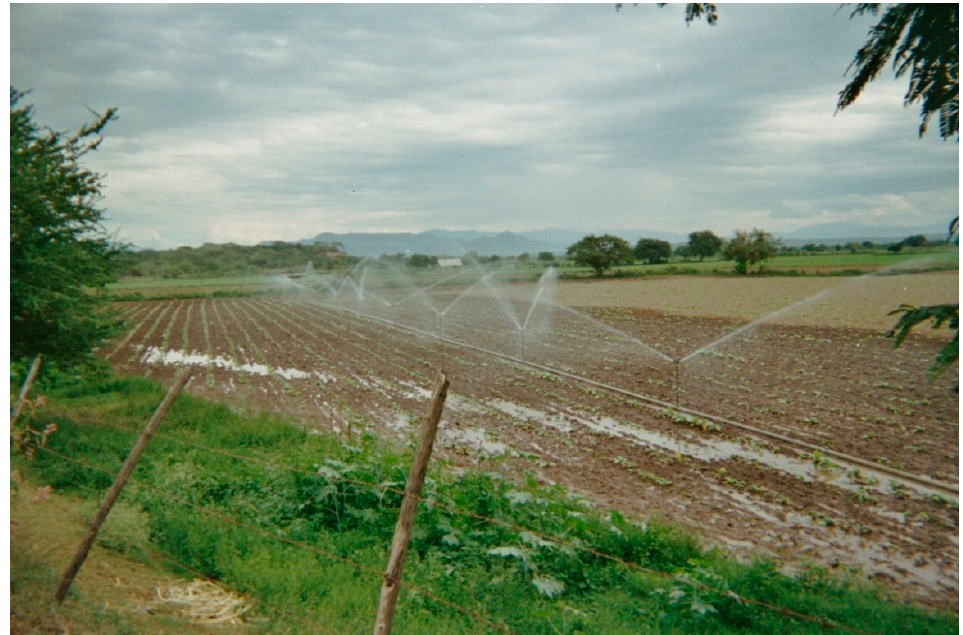
Figure 2. A pipeline with sprinklers.